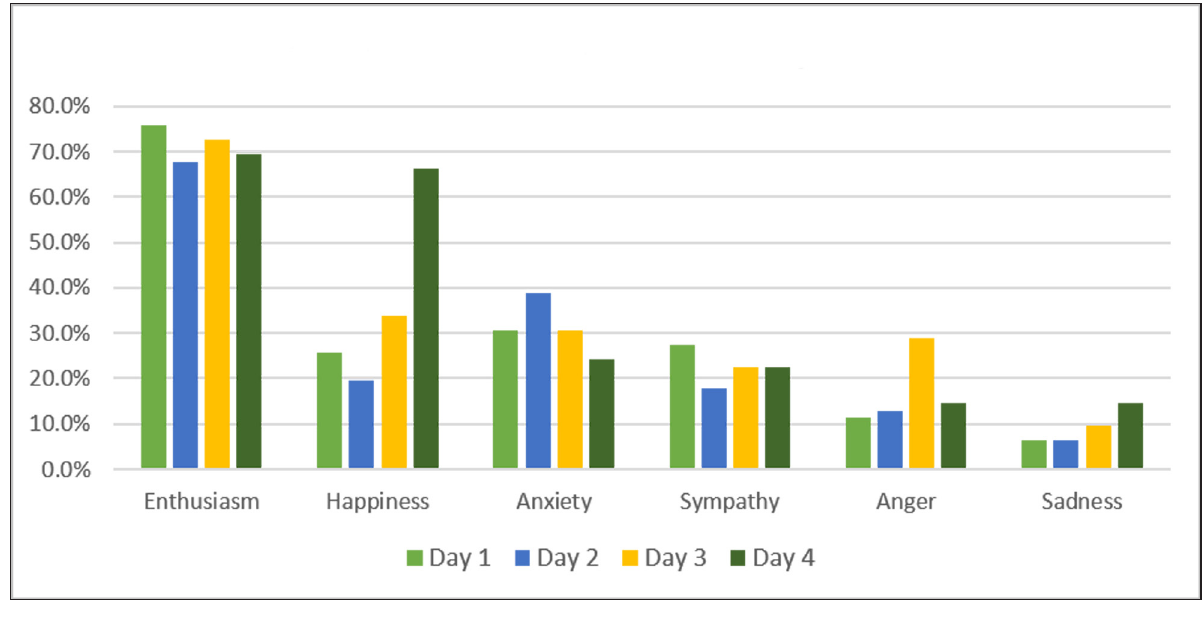
Figure 1: Reported Emotions by Day 2016 CIR.